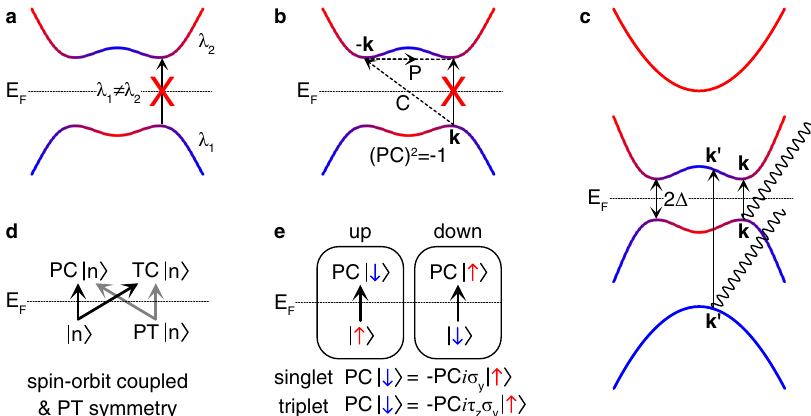
Fig. 2 Selection rules in clean superconductors. a Selection rule by unitary symmetry. λ 1,2 are eigenvalues of a k -local unitary symmetry operator. No optical excitation occurs between two states with different eigenvalues. b Selection rule by C symmetry. The case with C ¼ PC is shown. No optical transition occurs between PC-related states when (PC) 2 = − 1. c Optical excitation channels in C -symmetric superconductors in the clean limit. At low photon energies comparable to the superconducting gap 2 Δ , the relevant excitations are spectrum-inversion-symmetric (SIS) ones, i.e., from energy − E to E . For nondegenerate bands, they are transitions between C -related pairs. d , e Optical excitations in spin-degenerate systems with and without spin – orbit coupling, respectively. (here, the order of d and e has been changed in order to match the label in the fi gure.) In d , T ¼ PT symmetry with (PT) 2 = − 1 imposes Kramers degeneracy. As a state n j i can be excited to one of two SIS states, PC n j i and PT ð PC n j iÞ ¼ TC n j i , the excitation from n j i is possible even when one transition channel, from n j i to PC n j i , is blocked by (PC) 2 = − 1. The same applies to the excitation from PT n j i . In e , the boxes labeled up and down indicate the spin up and down eigenspace ( s z = ℏ /2 and − ℏ /2, respectively). Since C reverses the spin (the anti-particle of a spin-up electron carries the down spin) while P does not change the spin, PC reverses the spin. Its combination with the spin rotation around the y axis, which is i σ y for spin-singlet pairing, acts within a s z sector. For spin-triplet pairing, the spin rotation around the y- axis acts on the particle and hole sector with an opposite sign due to the spin carried by the Cooper pair, so the additional τ z is introduced (see section 3 in the “ Methods ” ). Optical excitations are forbidden when C de fi ned within a spin sector, which is − i PC σ y for singlet pairing ( − i PC τ z σ y for triplet pairing), satis fi es C 2 ¼ (cid:2) 1. E F is the Fermi level in all fi gures.